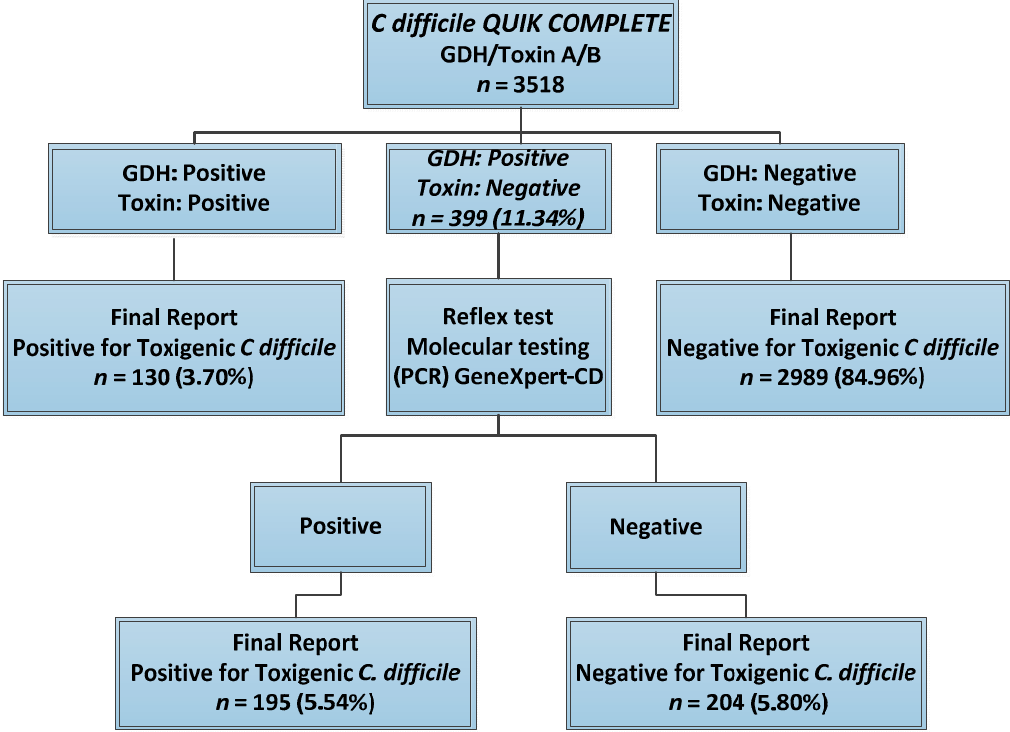
Figure 2. Post-implementation statistics of C. difficile testing using the two-step algorithm.